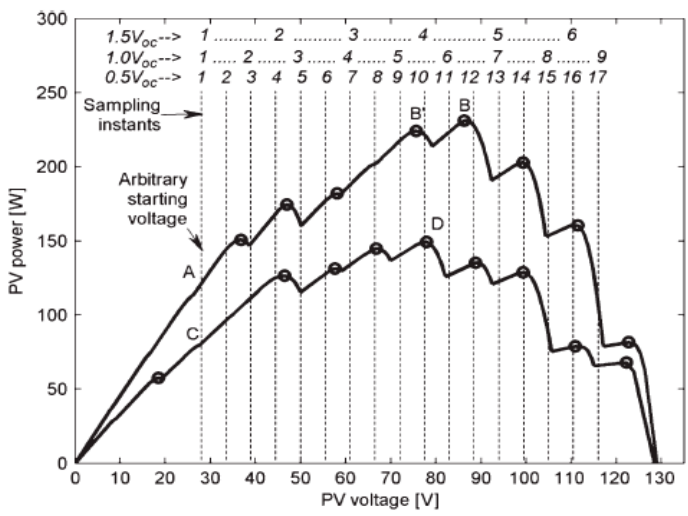
Figure 16. Fixed-step voltage window search [55].